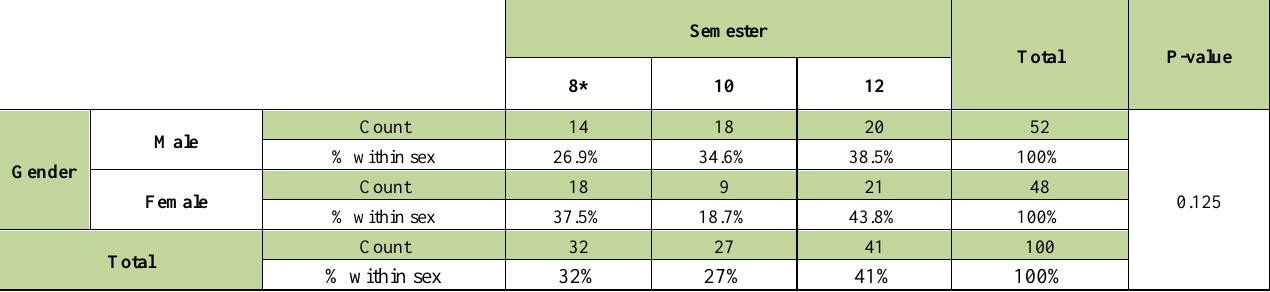
Table 2. Frequency distribution of studied samples based on the school year by gender.